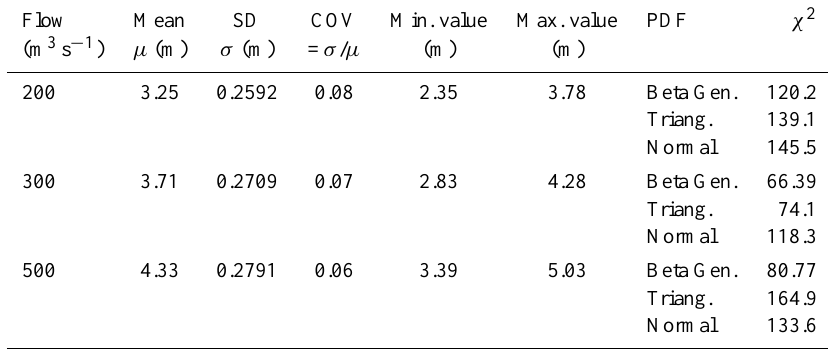
Table 3. Uniform flow model. Adaptation of PDFs to water depth with triangular distributions for n i (1000 simulations). Flow Mean